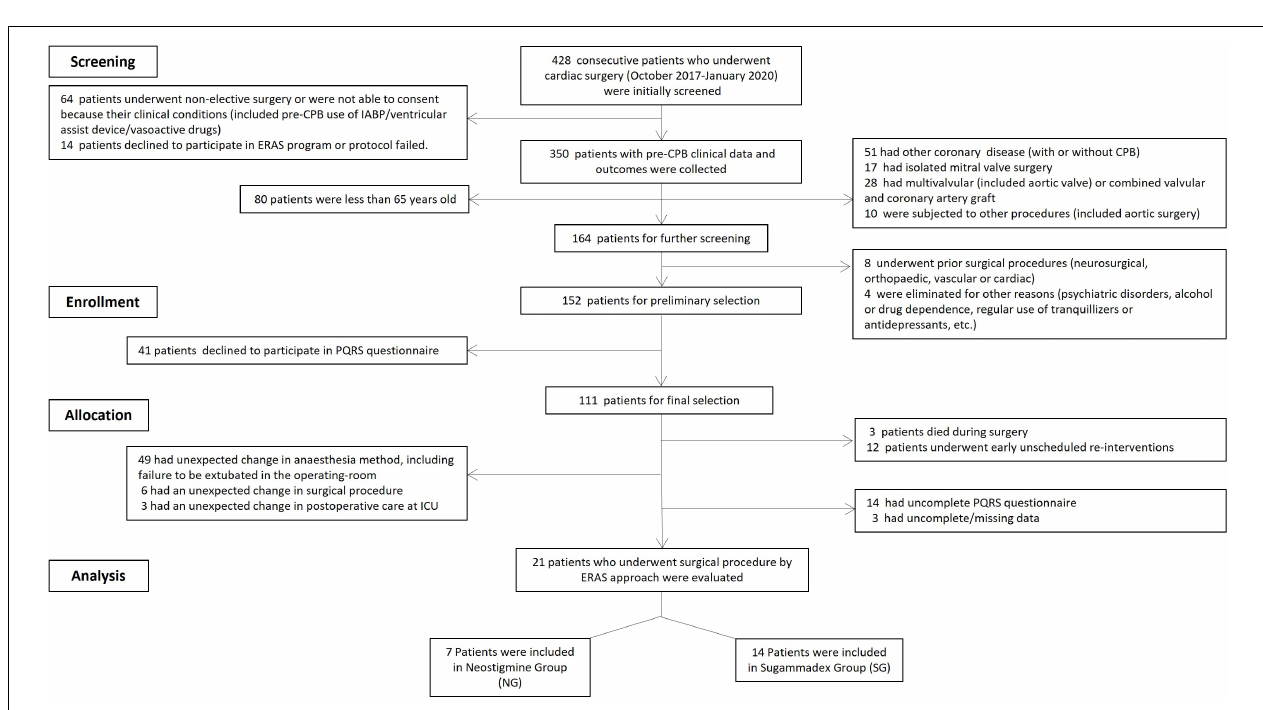
FIGURE 1 | Perception of the use of sugammadex in daily clinical practice by surveyed anesthesiologists. The degree of conformity is evaluated by three essential questions: (dark blue group) useful tool in enhanced recovery after surgery (ERAS) protocols, (yellow group) patient looks like feeling better after surgical procedures, and (green group) sugammadex could facilitate early awareness.